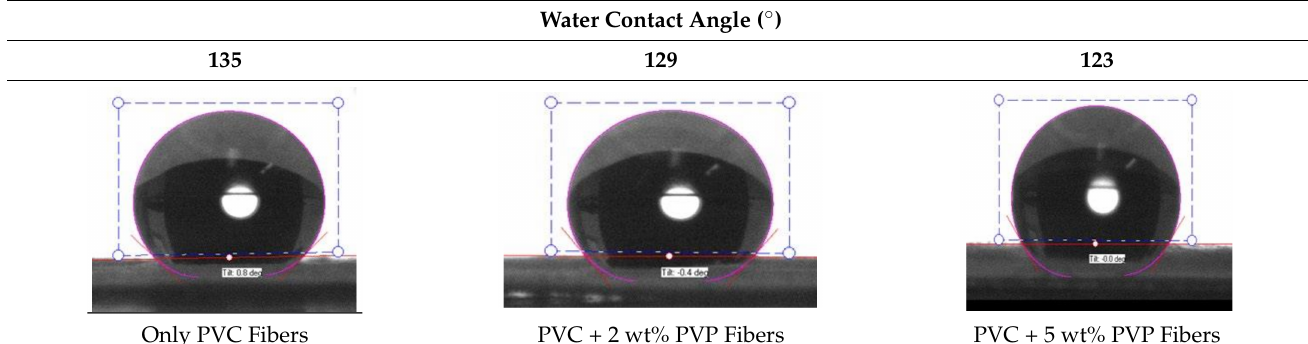
Table 8. The contact angle values for electrospun PVC with PVP